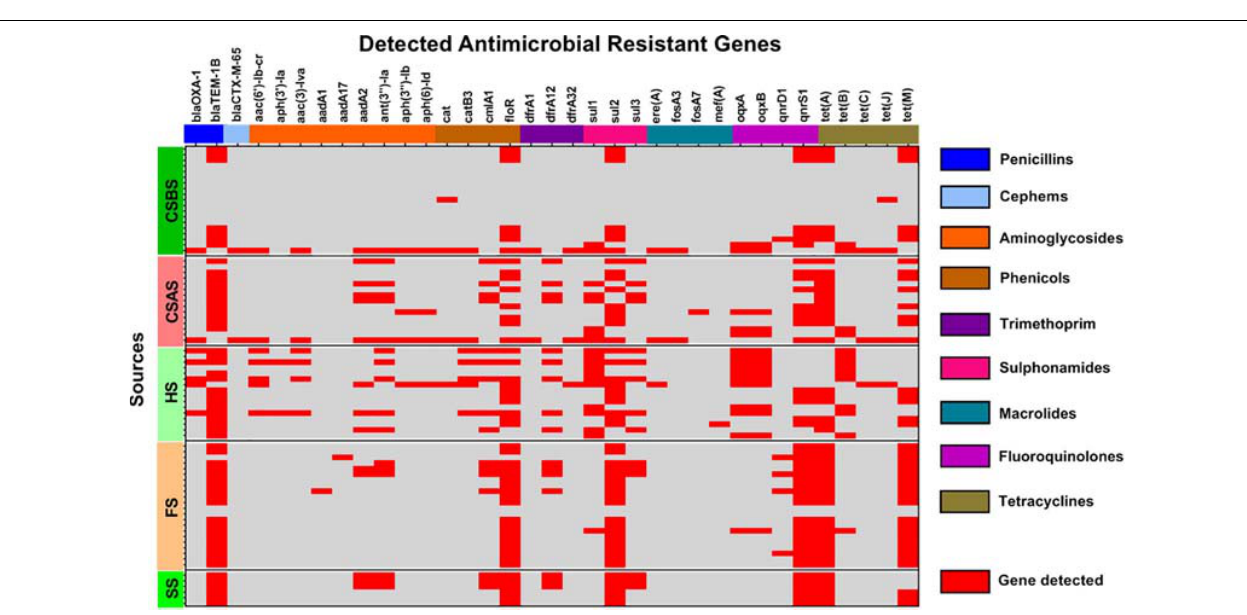
FIGURE 2 | Heatmap of antimicrobial resistance of Salmonella isolated from pig slaughtering process according to serovars and sampling sources. The isolates of Salmonella Typhimurium ST34 were resistant to all the tested antimicrobial agents (A) , while Salmonella isolated from HS were the most resistant to the tested antimicrobial agents (B) . The numbers in cells correspond to the percentage (%) of antimicrobial resistance isolates. CSBS, carcass swabs before splitting; CSAS, carcass swabs after splitting; HS, hepatobiliary samples; FS, fecal samples; SS, sewer samples.